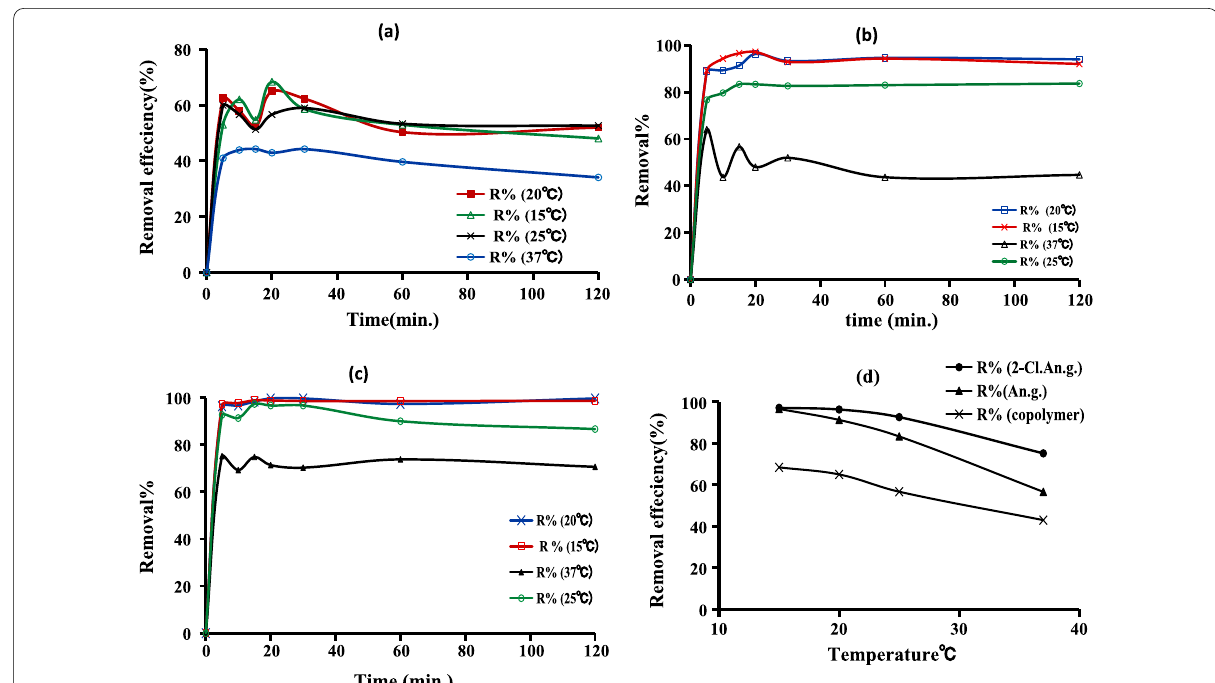
Fig. 8 Removal efficiency (%) of copolymer ( a ), aniline graft ( b ) and 2‑chloroaniline graft ( c ) and with time contacts 20 m, 15 m and 5 m ( d ) at temperatures 15 °C, 20 °C, 25 °C and 37